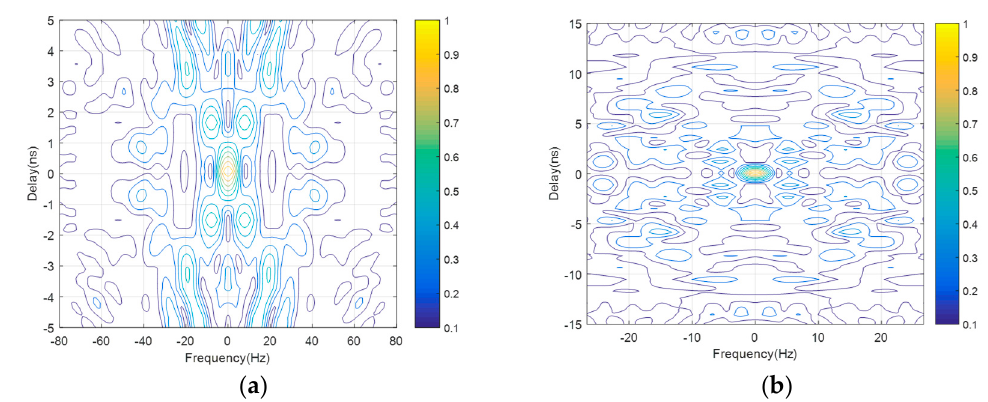
Figure 6. Ambiguity Function (AF) contours showing delay-Doppler resolution at ( a ) iteration 1 and ( b ) iteration 20, which demonstrates smaller focal area in ( b ) as compared with ( a ).